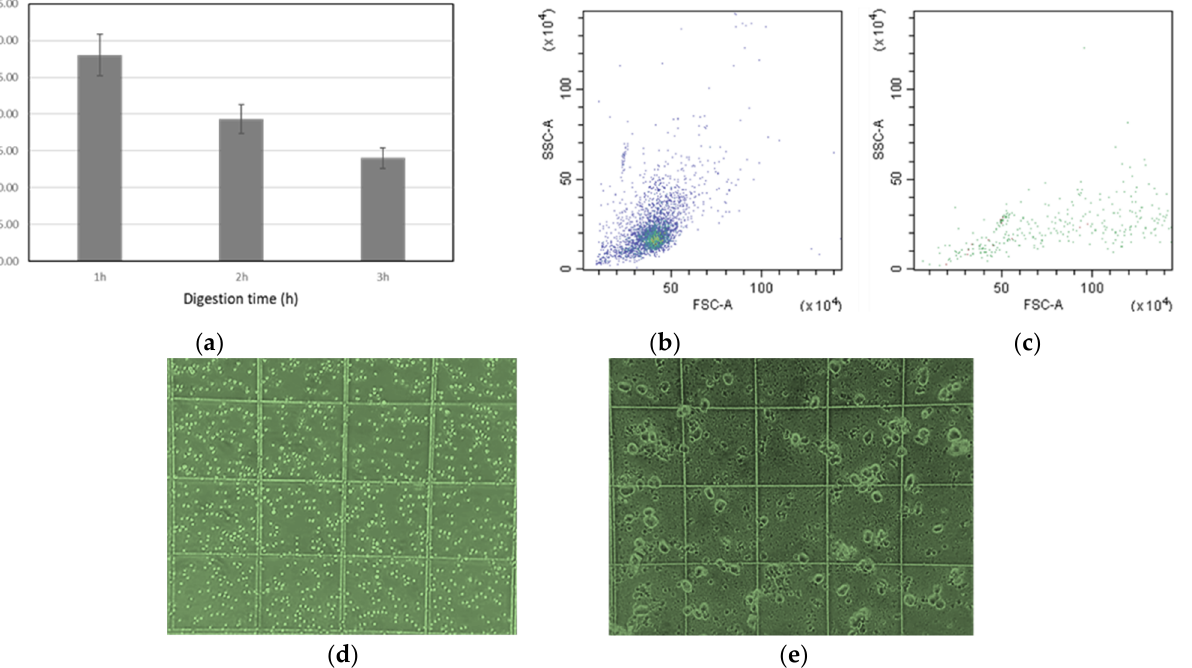
Figure 2. ( a ) Recovery of the disaggregation process using Accutase in liver tissues, calculated as pellet weight with respect to the tissue weight; ( b ) flow cytometry analysis of the cells that were derived from the spleen and ( c ) from liver. Micrographs of the cells that were obtained after enzymatic digestion from rat ( d ) spleen and ( e ) liver tissues (0.25 mm × 0.25 mm grid size). The obtained results by flow cytometry were confirmed by microscopy observations.